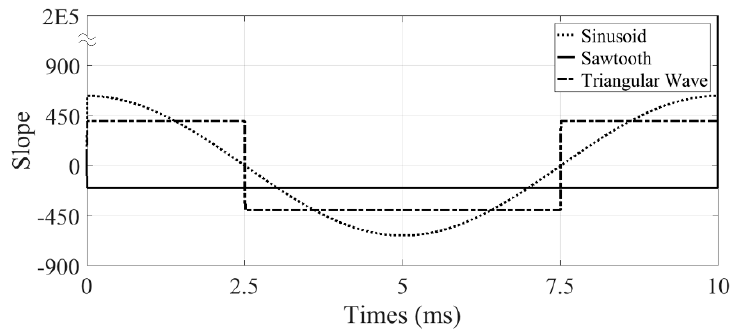
Figure 9. The slope of the three modulation signals in Figure 7.